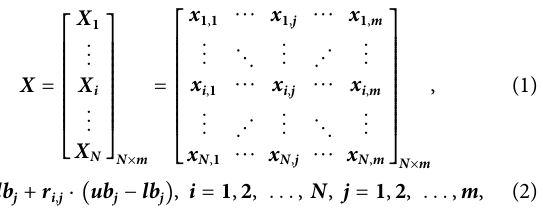
(cid:129) The upperparts are a deep-glossy brown, while the breast is white and sometimes streaked with brown, and the underparts are pure white. (cid:129) The head is white with a black mask across the eyes, reaching to the sides of the neck. (cid:129) The irises of the eyes are golden to brown, and the transparent nictitating membrane is pale blue. (cid:129) The feet are white with black talons and bill is black with a blue cere. (cid:129) Osprey has narrow-long wings and a short tail.